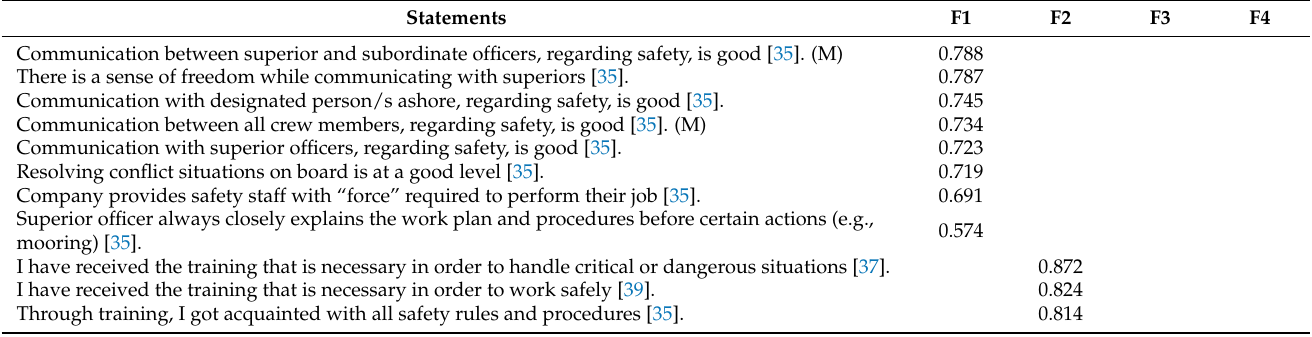
Table 1. Exploratory factor analysis of shipboard environment related variables ( n =